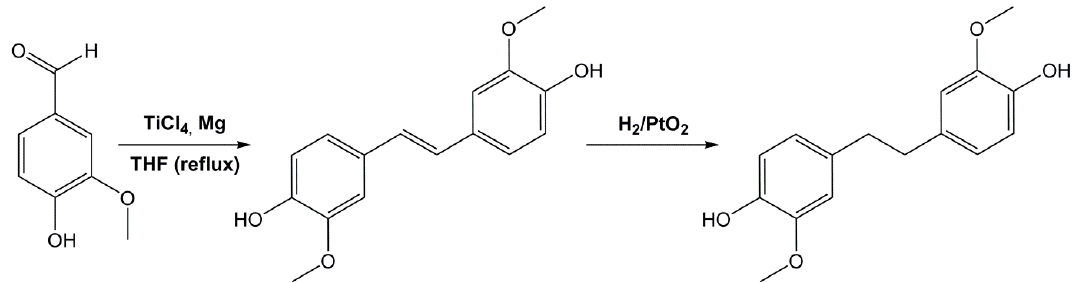
Molecules 2017 , 22 , 149 25 of 47 Figure 21. Epoxy resin based on p -aminophenol and p -hydroxybenzaldehyde synthesized by Duann et al. [161].